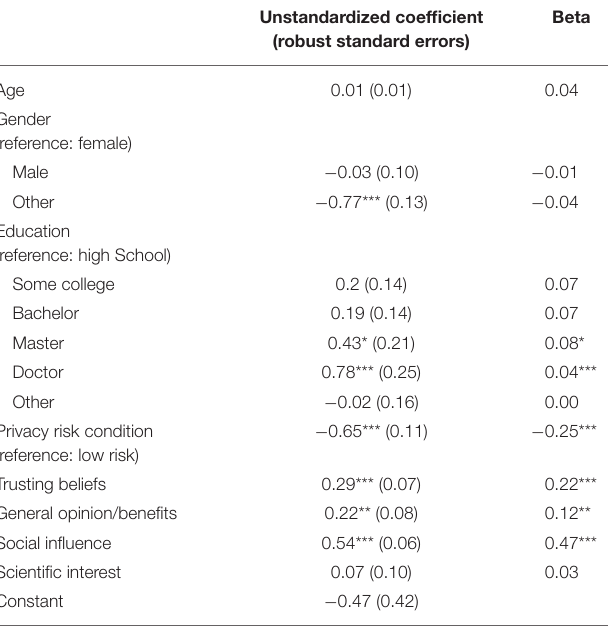
TABLE 2 | Regression of robot use intentions on demographics, privacy, trusting beliefs, general opinion/beliefs, social influence, and scientific interest. Unstandardized coefficient (robust standard